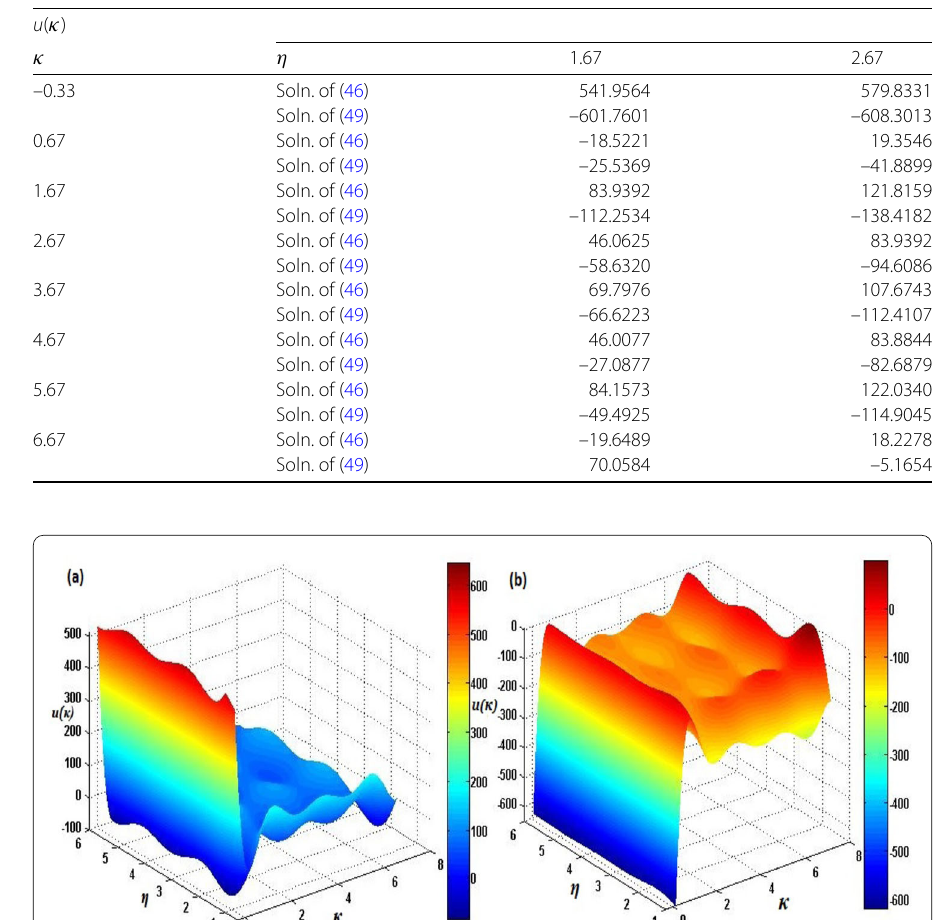
Table 1 Numerical values of u ( κ ) with step size 1